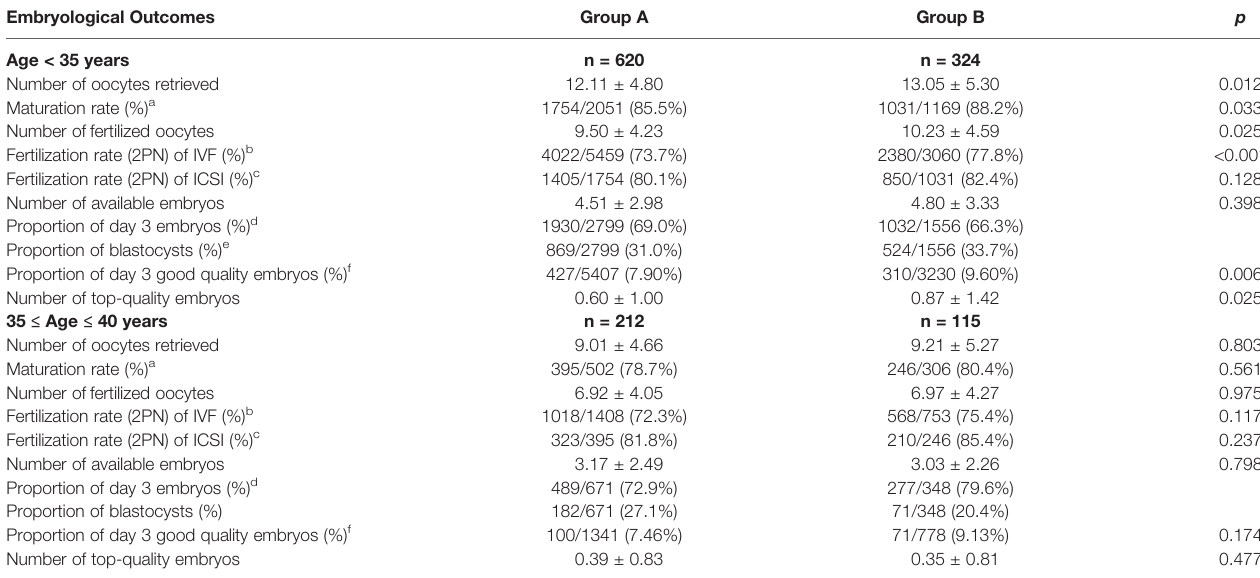
GroupAreceivedcetrorelixdailyuntilthetriggerday;GroupBreceivedcetrorelixdaily,ceasingcetrorelixonthetriggerday.Twosubgroupsweredividedaccordingtoage,Age<35years and 35 ≤ Age ≤ 40 years. Data is expressed as mean ± SD, or number (percentage). a Maturation rate (%) = No. of Metaphase II oocytes/No. of oocytes retrieved in ICSI cycles. b Fertilization rate (2PN) of IVF (%) = No. of 2PN zygotes in IVF/No. of inseminated oocytes. c Fertilization rate (2PN) of ICSI (%) = No. of 2PN zygotes in ICSI/No. of microinjected oocytes. d Proportion of day 3 embryos (%) = No. of the day 3 available embryos/No. of the available embryos. e Proportion of blastocysts (%) = No. of the available blastocysts/No. of the available